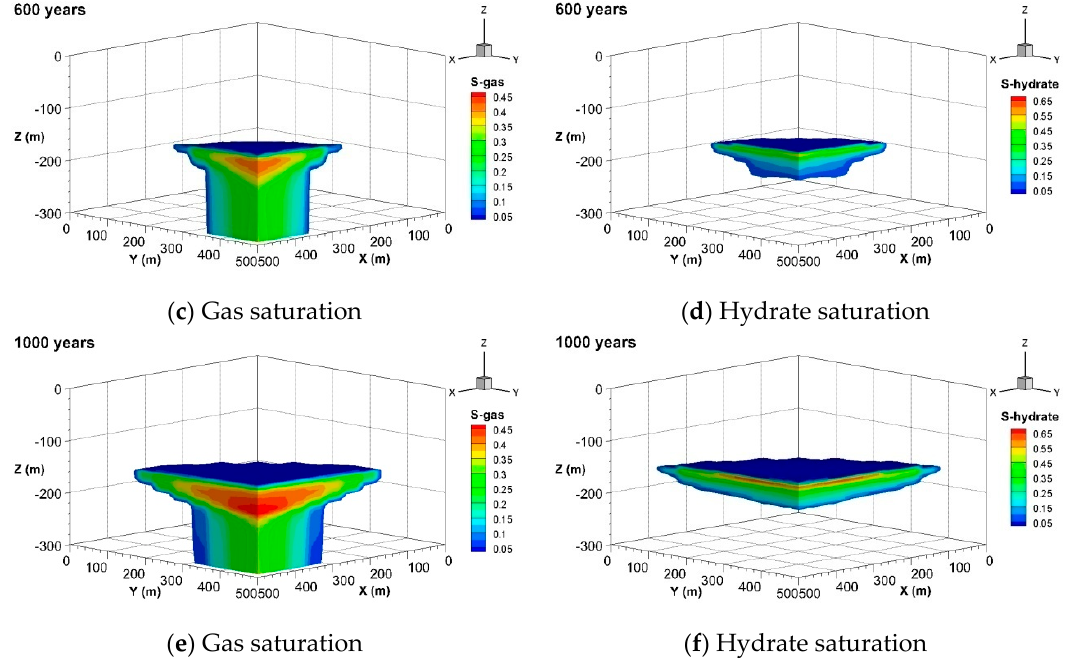
Figure 2. Gas and hydrate distribution at different simulated times (Base-case).